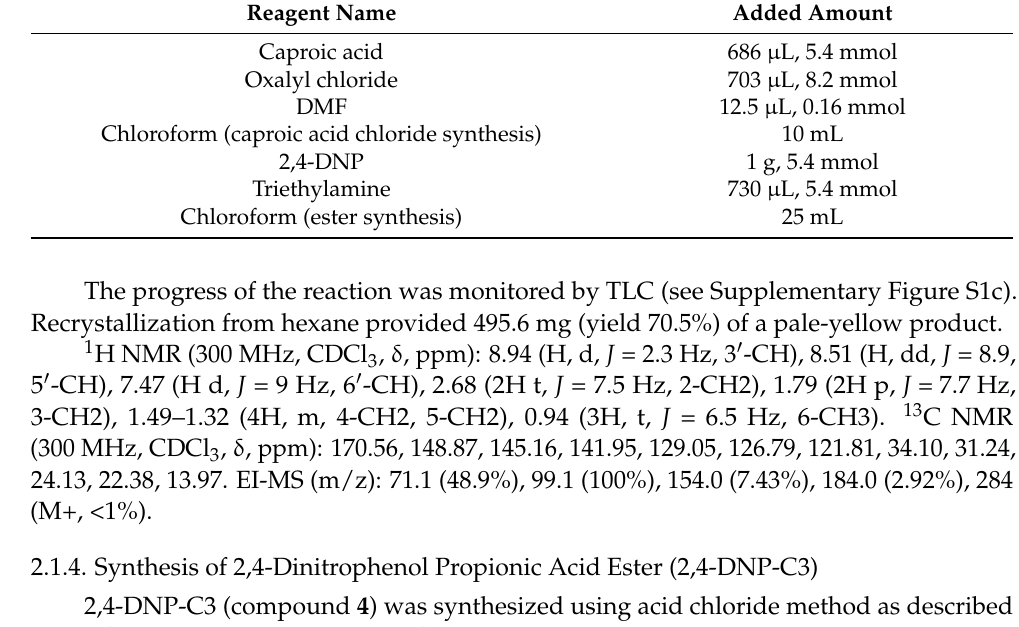
Table 2. Reagents ratio for 2,4-DNP-C3 (compound 4 ) synthesis. Reagent Name Added Amount Propionic acid 150 µ L, 2 mmol Oxalyl chloride 257 µ L, 3 mmol DMF 4.6 µ L, 0.06 mmol Chloroform (propionic acid chloride synthesis) 10 mL 2,4-DNP 368 mg, 2 mmol Triethylamine 257 µ L, 2 mmol Chloroform (ester synthesis) 25